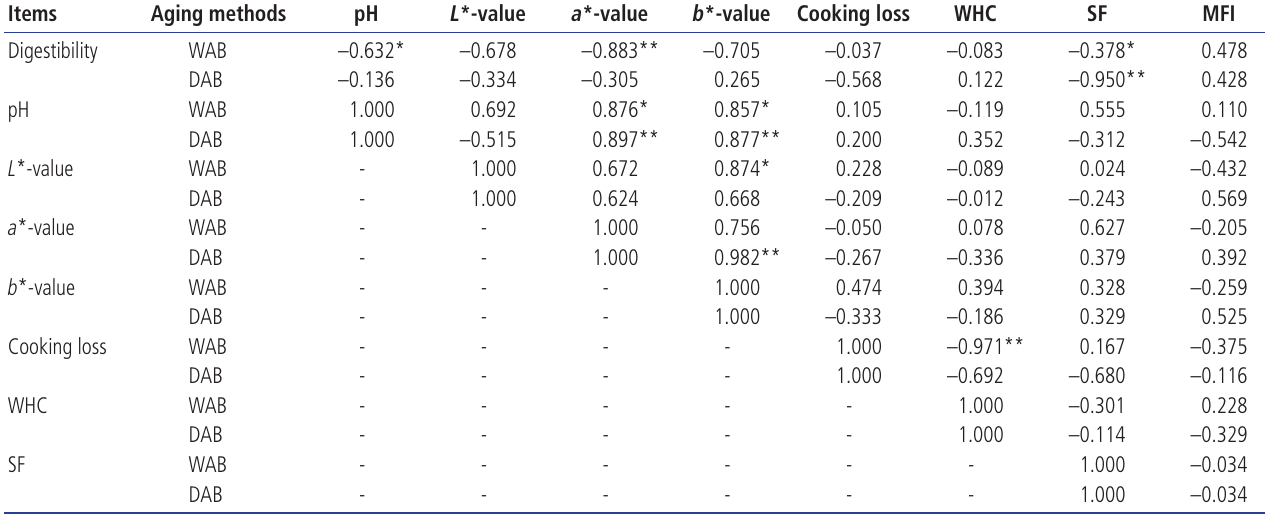
Table 2. Pearson correlation coefficients and probabilities of aging methods (WAB, DAB) on pH, color, cooking loss, water holding capacity, shear force, myofibrillar fragmentation index, and digestibility (%) of beef loins Items Aging